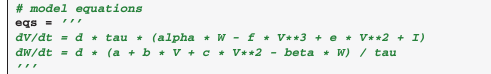
Code 3 | State equations of the generic plane oscillator as scripted to run the simulation in the Brian simulator. The description of the parameters are explained in the API documentation and will be discussed in the context of dynamical systems